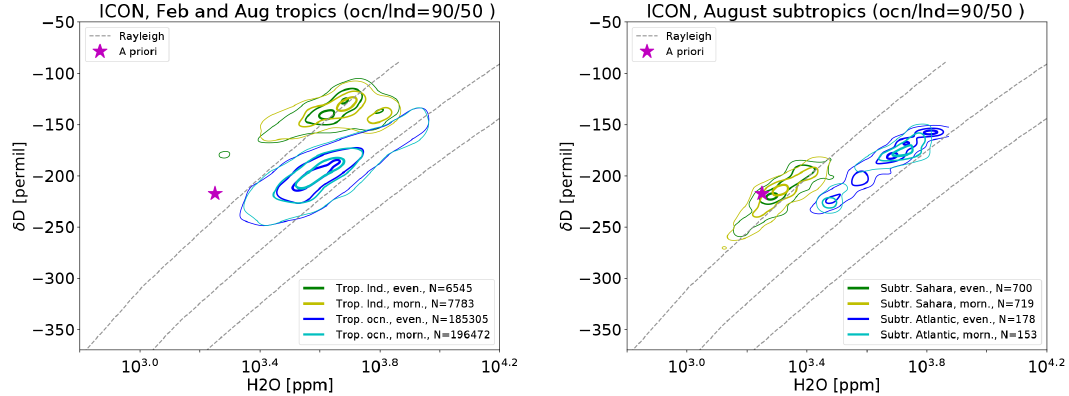
Figure 5. As Fig. 4 for ICON-ART-Iso. In addition to the land–ocean mask, land data must pass the condition q lnd v /q v > 0 . 5 and ocean data must pass q ocn v /q v > 0 .